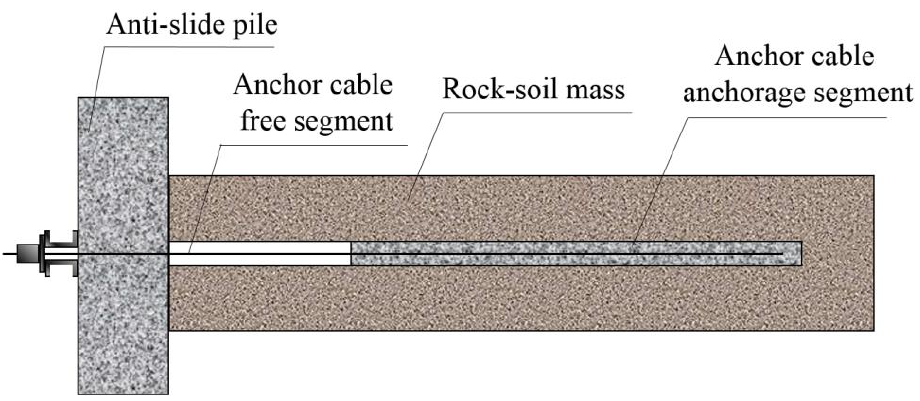
Figure 4. Schematic diagram of pile – anchor structure.